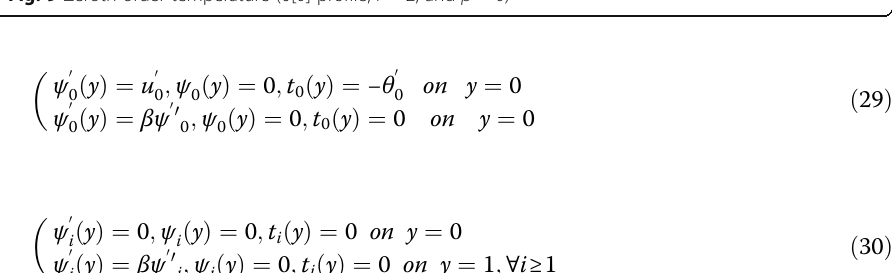
Fig. 9 Zeroth-order temperature ( θ [0] profile, r = 2, and β = 0)